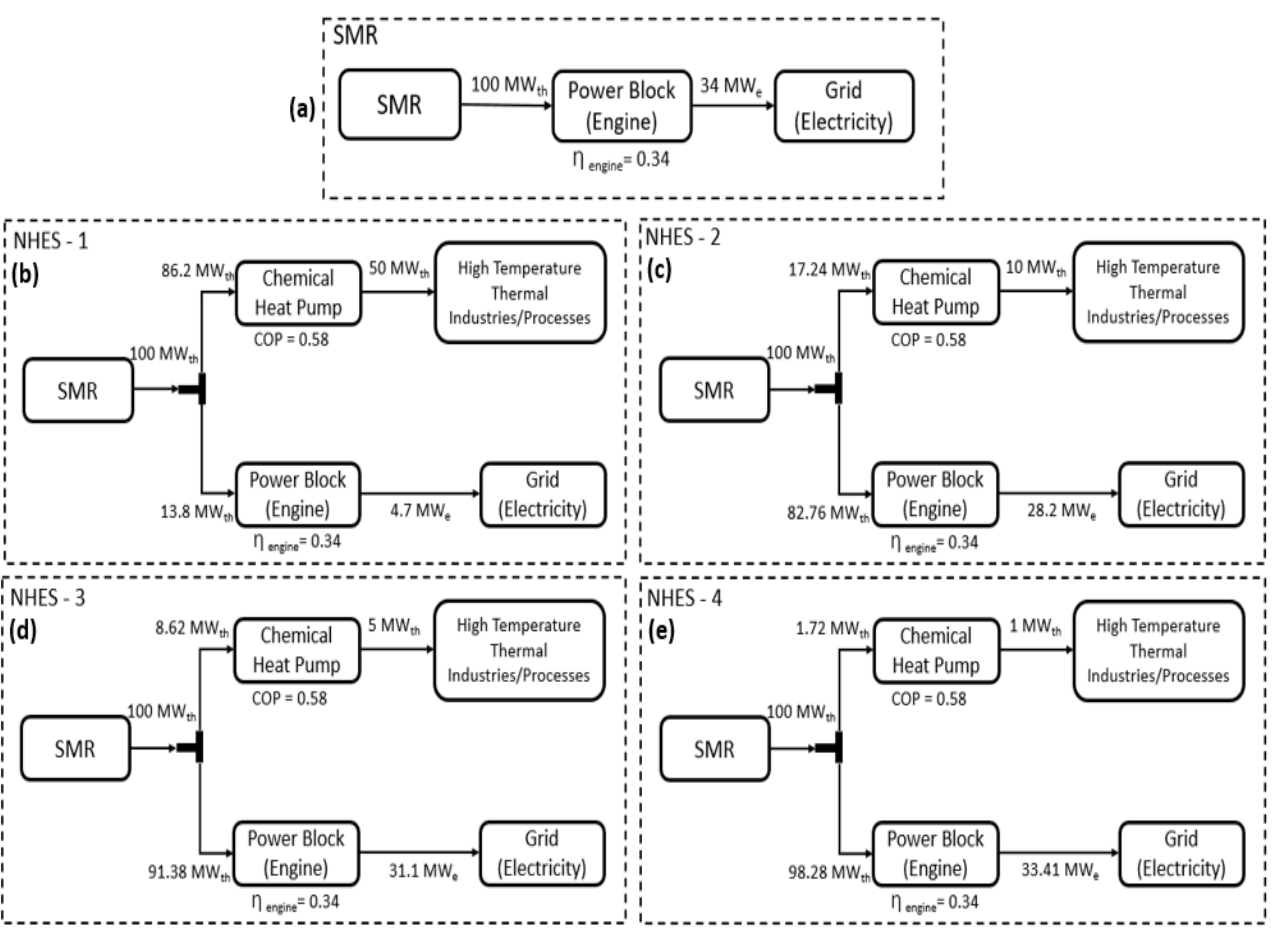
Figure 6. Advanced SMR and SMR-ChHP combined scenarios ( a ) base case SMR generating electricity; ( b – e ) SMR-ChHP coupled system generating heat and electricity in different proportions.